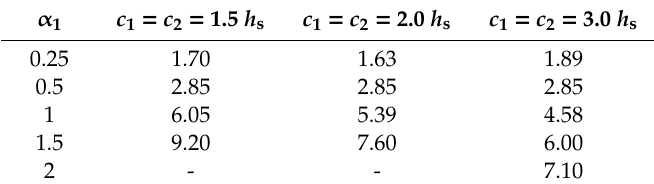
Table 3. Minimum values of the parameter 𝛼 2 , which satisfies the condition (2)—ACI318.